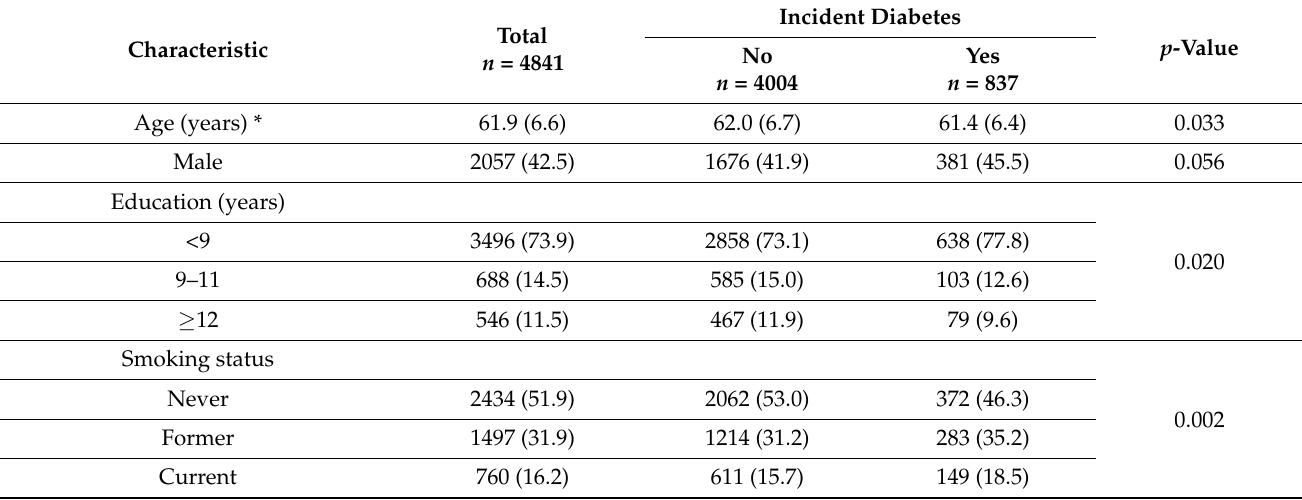
Table 1. Baseline characteristics of study